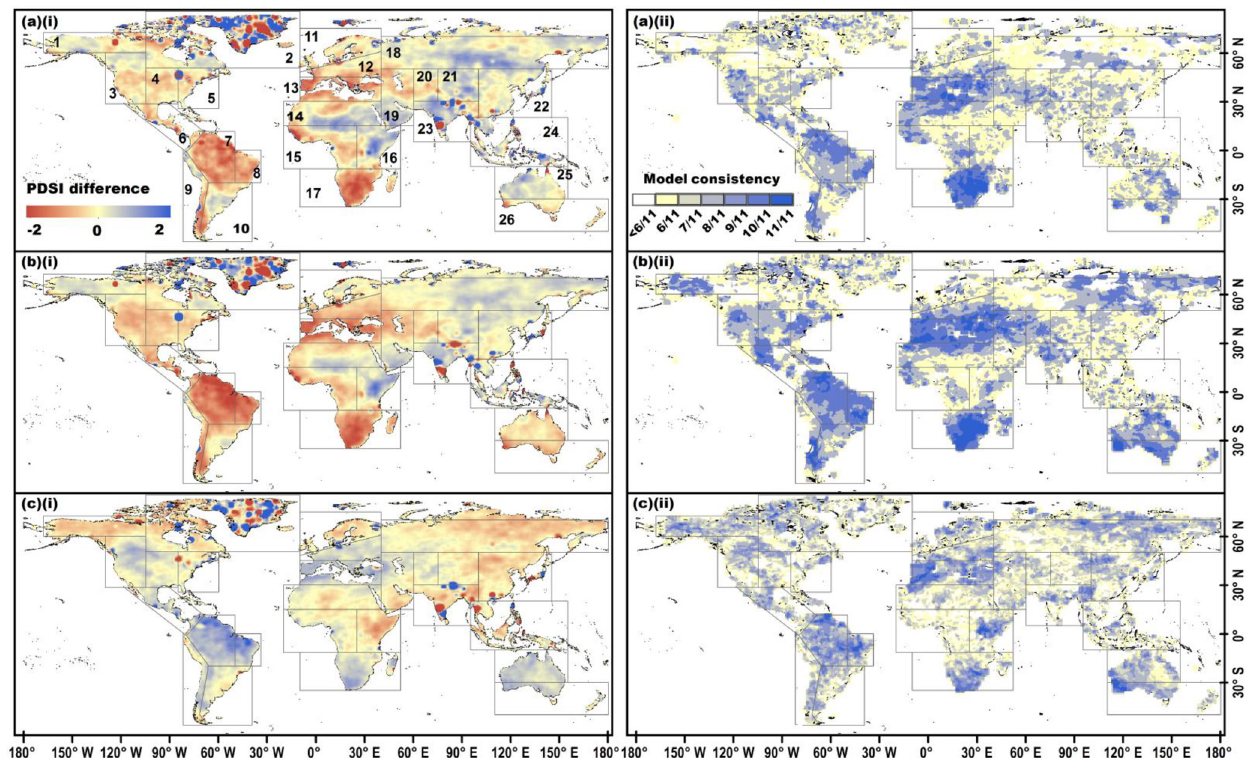
Figure 3. Changes in multi-model ensemble mean PDSI (i) and model consistency (ii) on a spatial resolution of 0.5 ◦ × 0.5 ◦ . Panel (a) is from the baseline period to the 1.5 ◦ C warmer world, panel (b) is from the baseline period to the 2 ◦ C warmer world and panel (c) is (a) – (b) . Robustness of projections increases with a higher model consistency and vice versa. The gray boxes show the world regions adopted by IPCC (2012), which are labeled in (a)(i) using the ID numbers defined in Table 2. The legend in (a)(i) applies to (b)(i) and (c)(i) and the legend in (a)(ii) applies to (b)(ii) and (c)(ii)